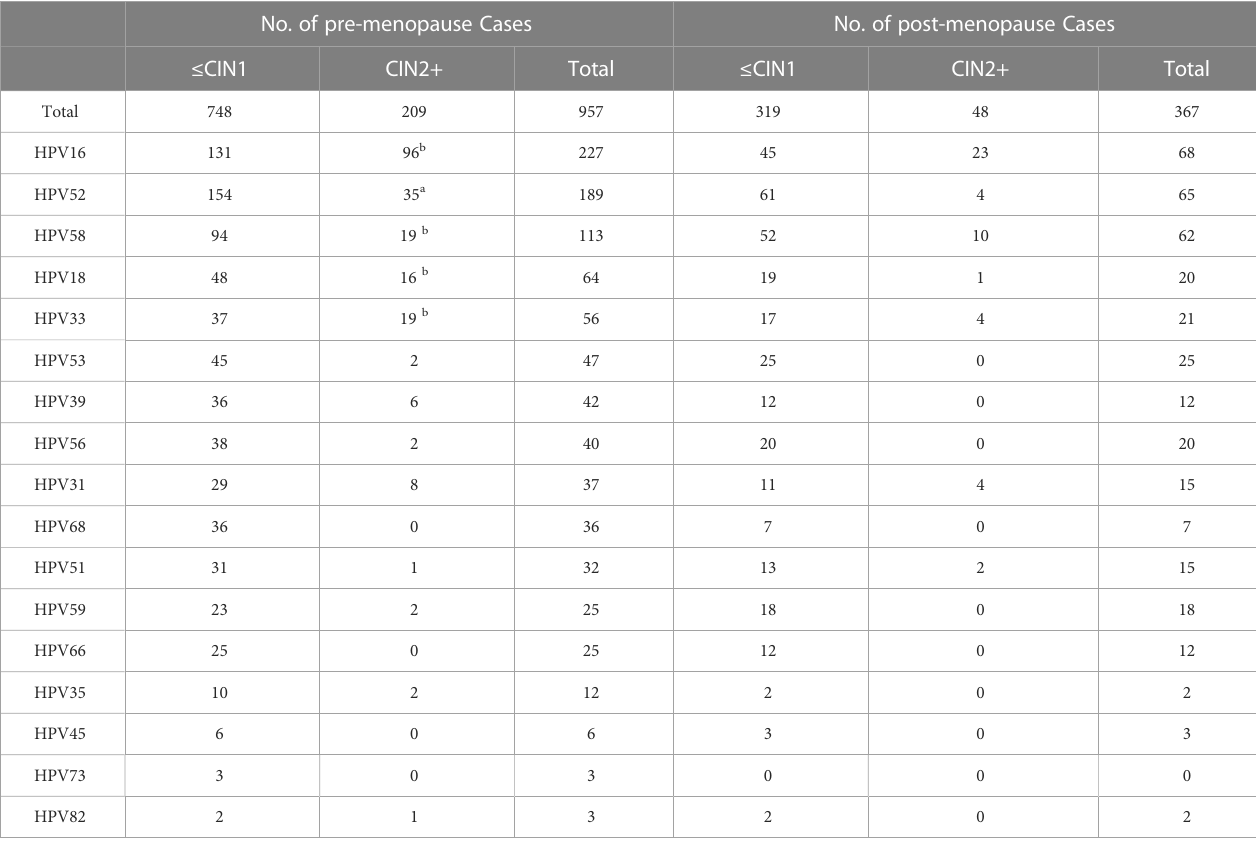
TABLE 6 Histopathologic results for pre- and post-menopausal women with ASC-US according to single HPV